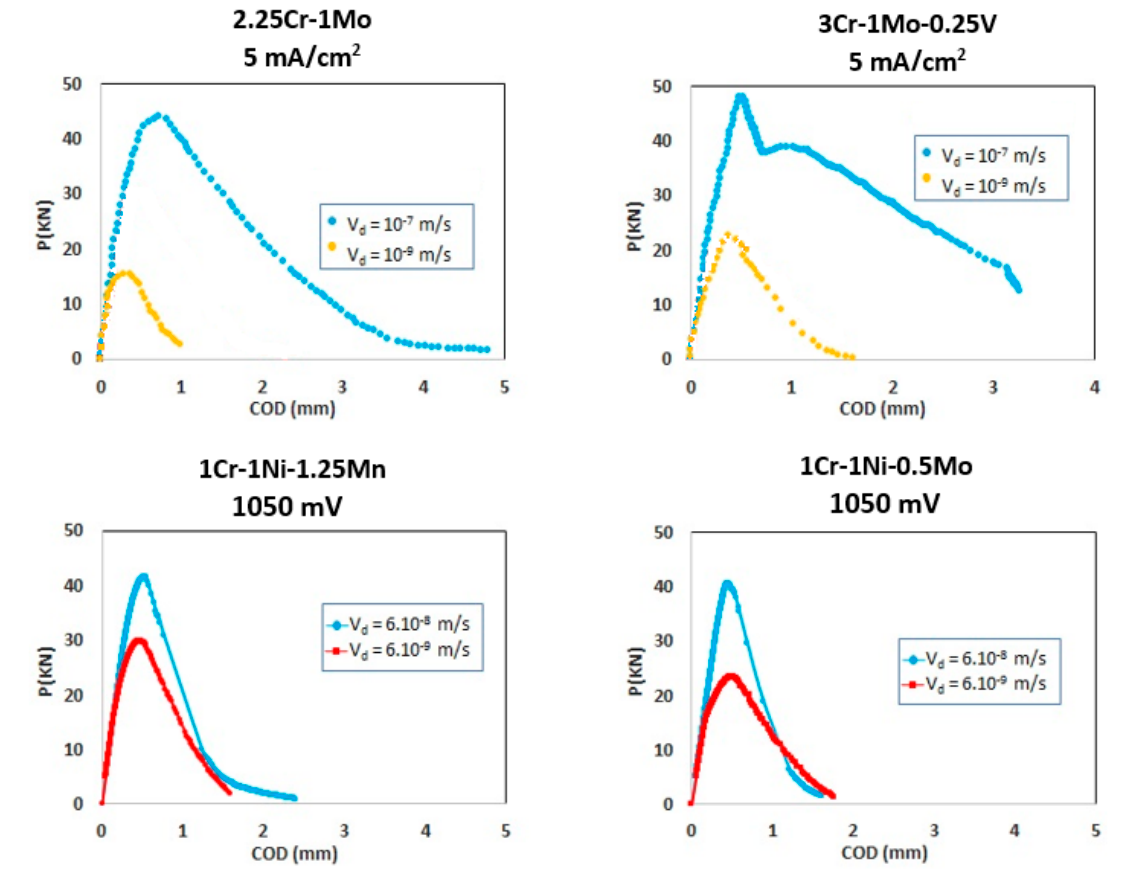
Figure 13. P-COD registers from the slow rate tests in the environment.